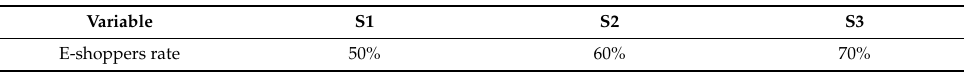
Table 2. Value changes to develop the